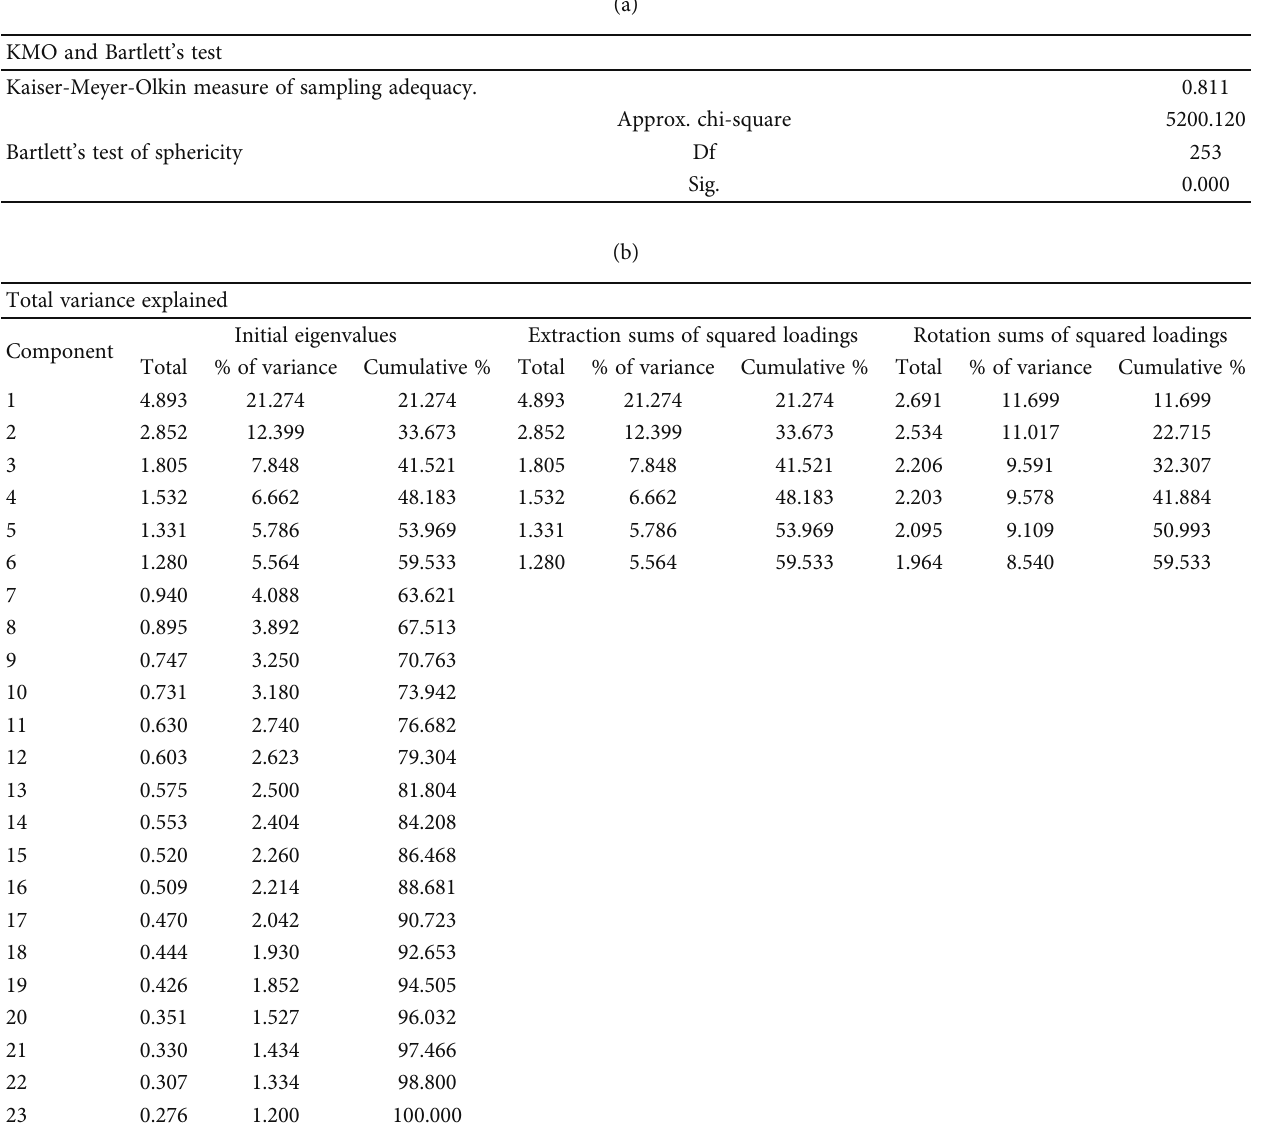
Table 4: Result of factor analysis